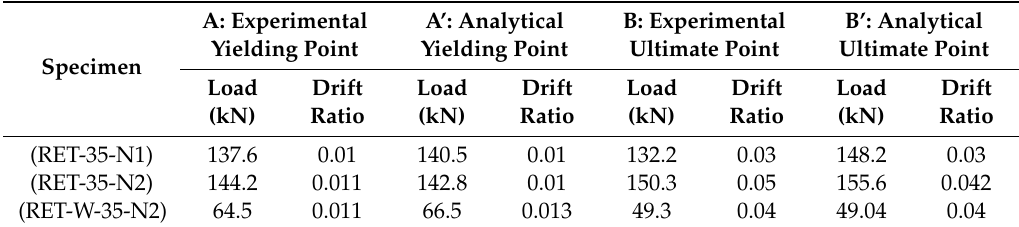
Table 12. Yielding and ultimate load-drift ratio data for the experimental and analytical results (modified from Ilki et al. [22]).